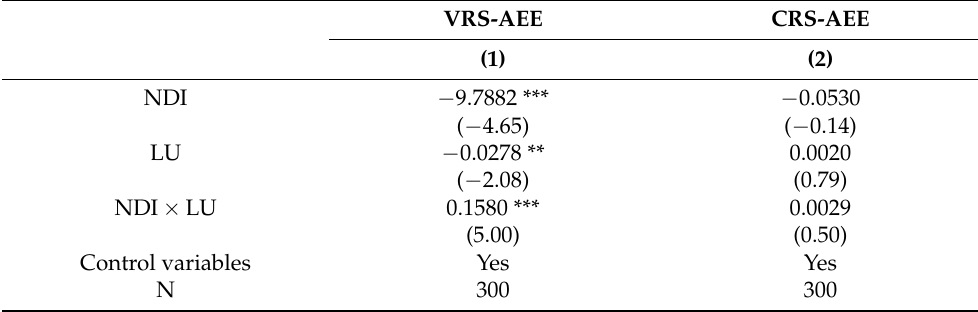
Table 12. Interaction effect of urbanization level and new digital infrastructure (explained